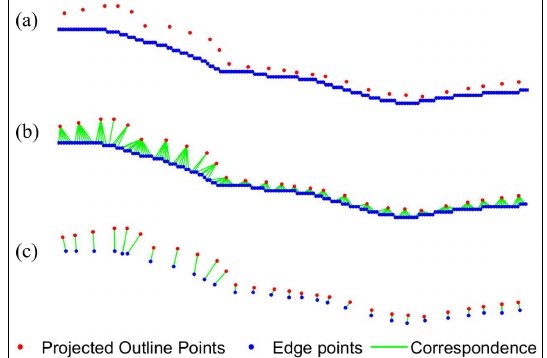
Figure 5. Projected outline points and edge points matching. (a) Points before matching, (b) matching from each edge points,